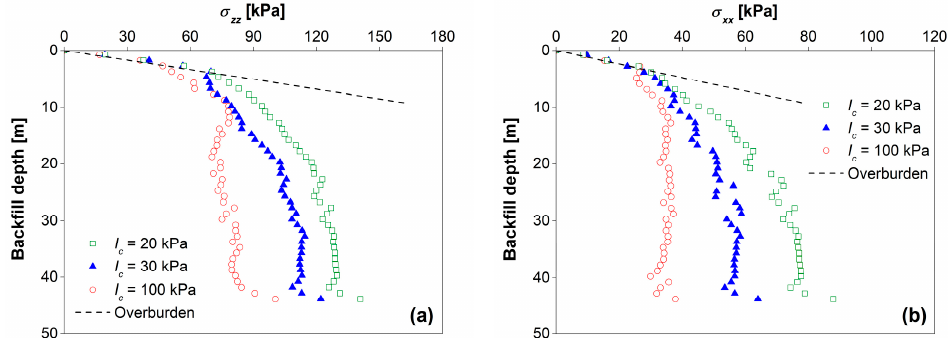
Figure 16. Stress distributions along the CL of the backfilled stope obtained from the numerical simulation conducted with the MSDP u -EPP model by considering different I c for ( a ) vertical stress σ zz and ( b ) horizontal stress σ xx.